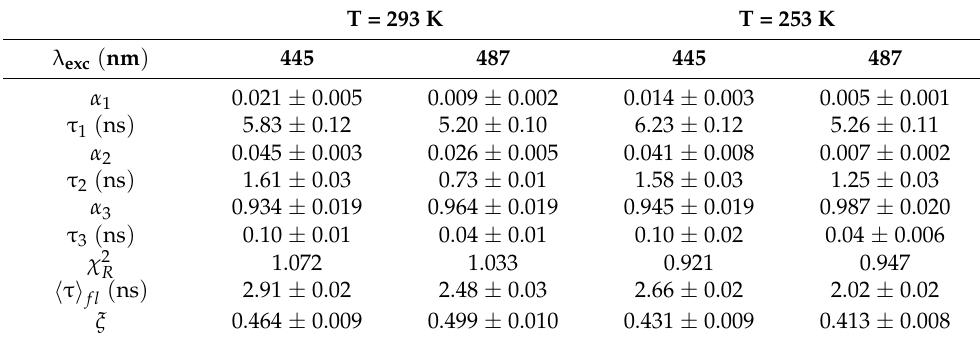
Table 4. Temperature-dependent parameters of the FMN fluorescence decay in PVA film rigid solution of concentration: C = 6.84 × 10 − 1 M fitted to the sum of three exponentials. The observation ( ns ) and the degree of nonexponentiality ξ wavelength is λ obs = 600 nm. The mean lifetimes (cid:104) τ (cid:105) fl were calculated from Equations (9) and (10), respectively. The parameters were estimated from the best fit with the data with calculated standard